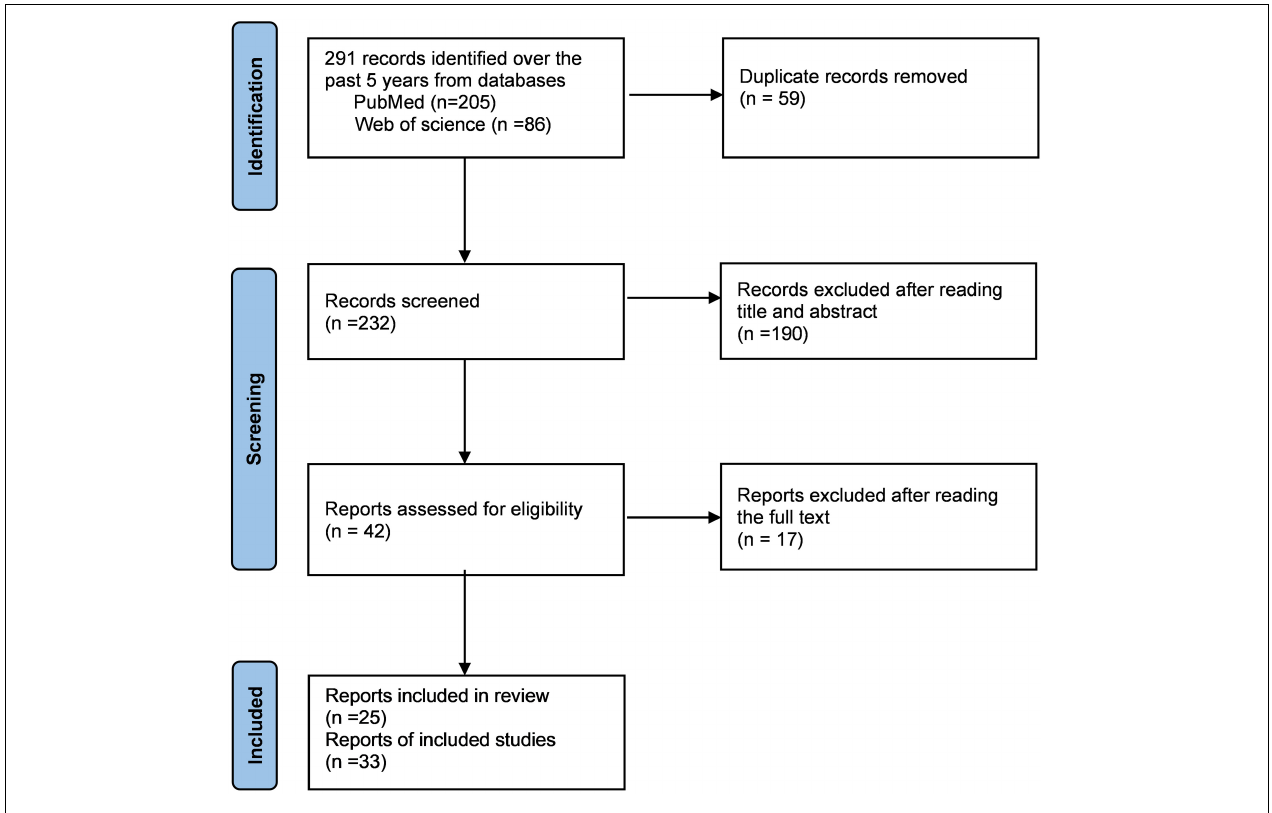
FIGURE 2 | Review